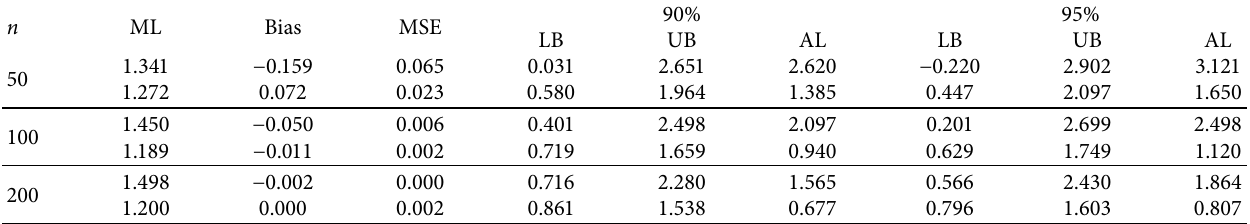
Table 3: ML estimates, biases, MSE, LB, UB, and AL of the TLIL model for α � 1.5, θ � 1.2.